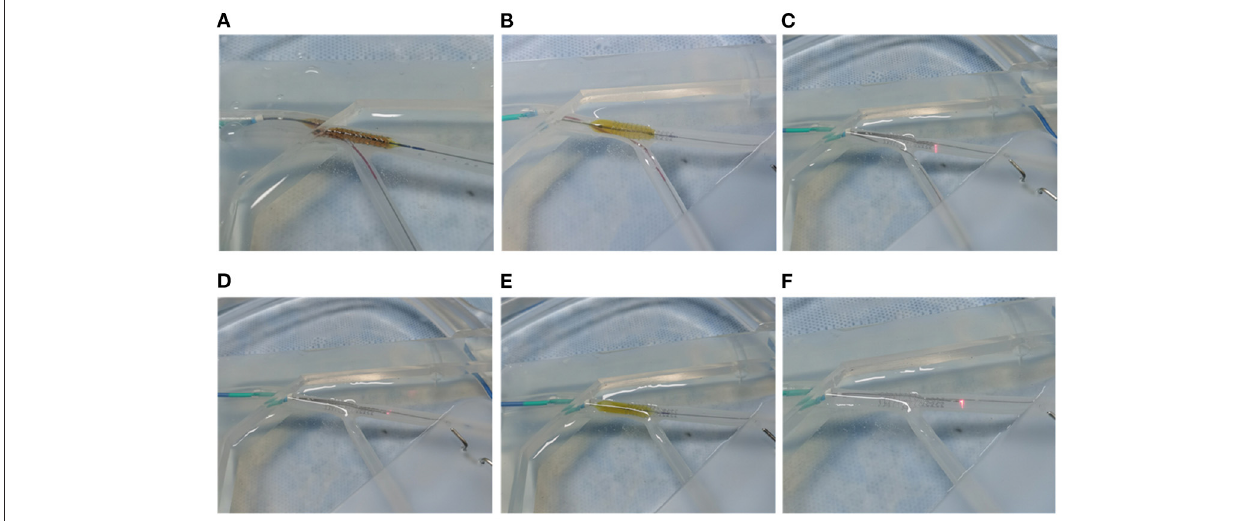
FIGURE 4 | JB-POT bench test procedures. (A) Perform MV stenting with a balloon jailed in the SB. (B) Perform POT pullback at the carina level with the jailed balloon maintained. (C) Retrieve the jailed balloon and perform OCT evaluation with the jailed wire remaining. (D) Perform OCT pullback after retrieving the jailed wire (experimental arm). (E) Perform POT at the carina level to correct the potentially JB-POT-induced stent distortion. (F) Perform the final OCT run (self-control arm).